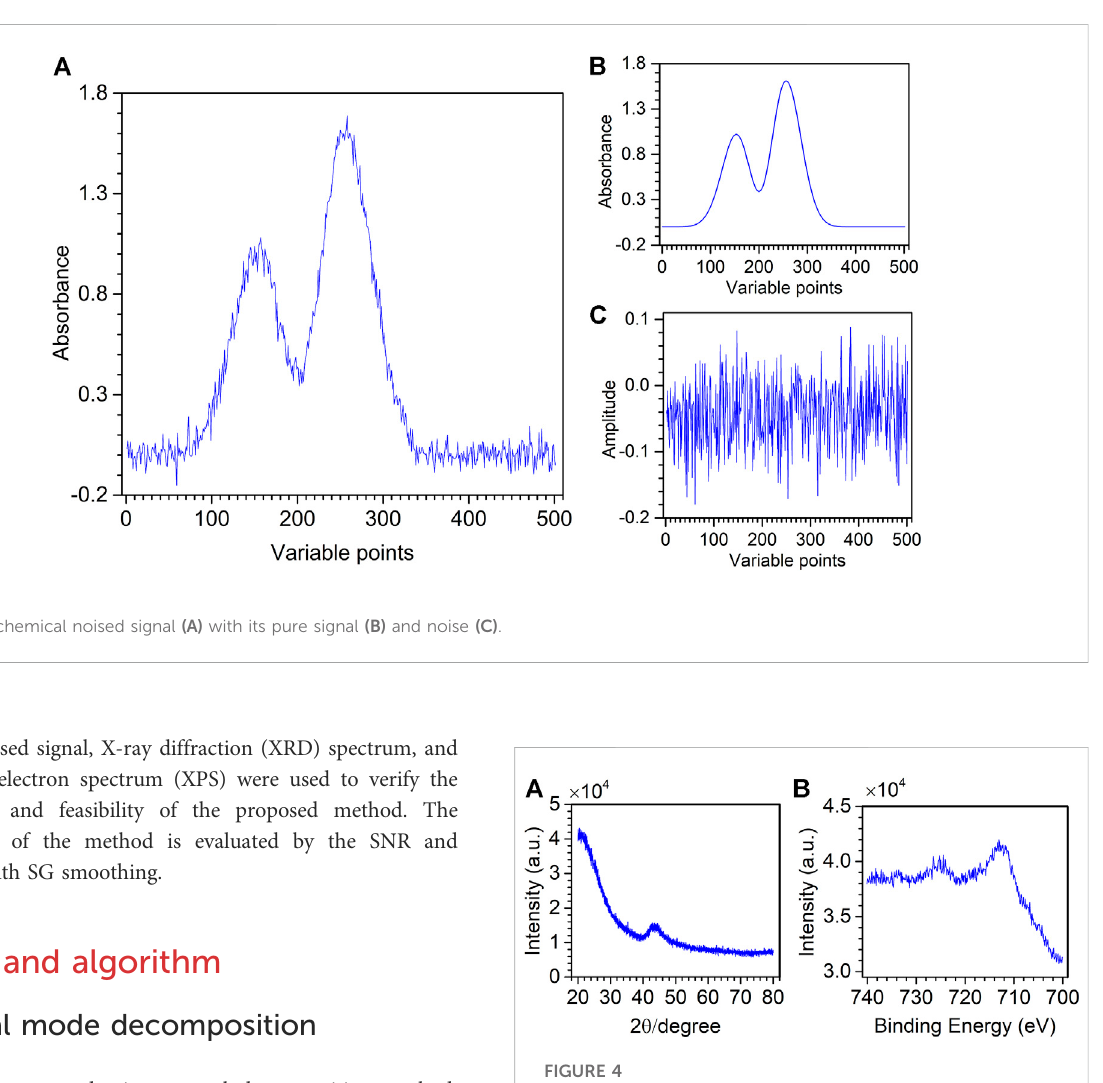
FIGURE 4 XRD spectrum of the Fe/SCN catalyst (A) and the XPS spectrum of the FeNiOS-NS catalyst (B)